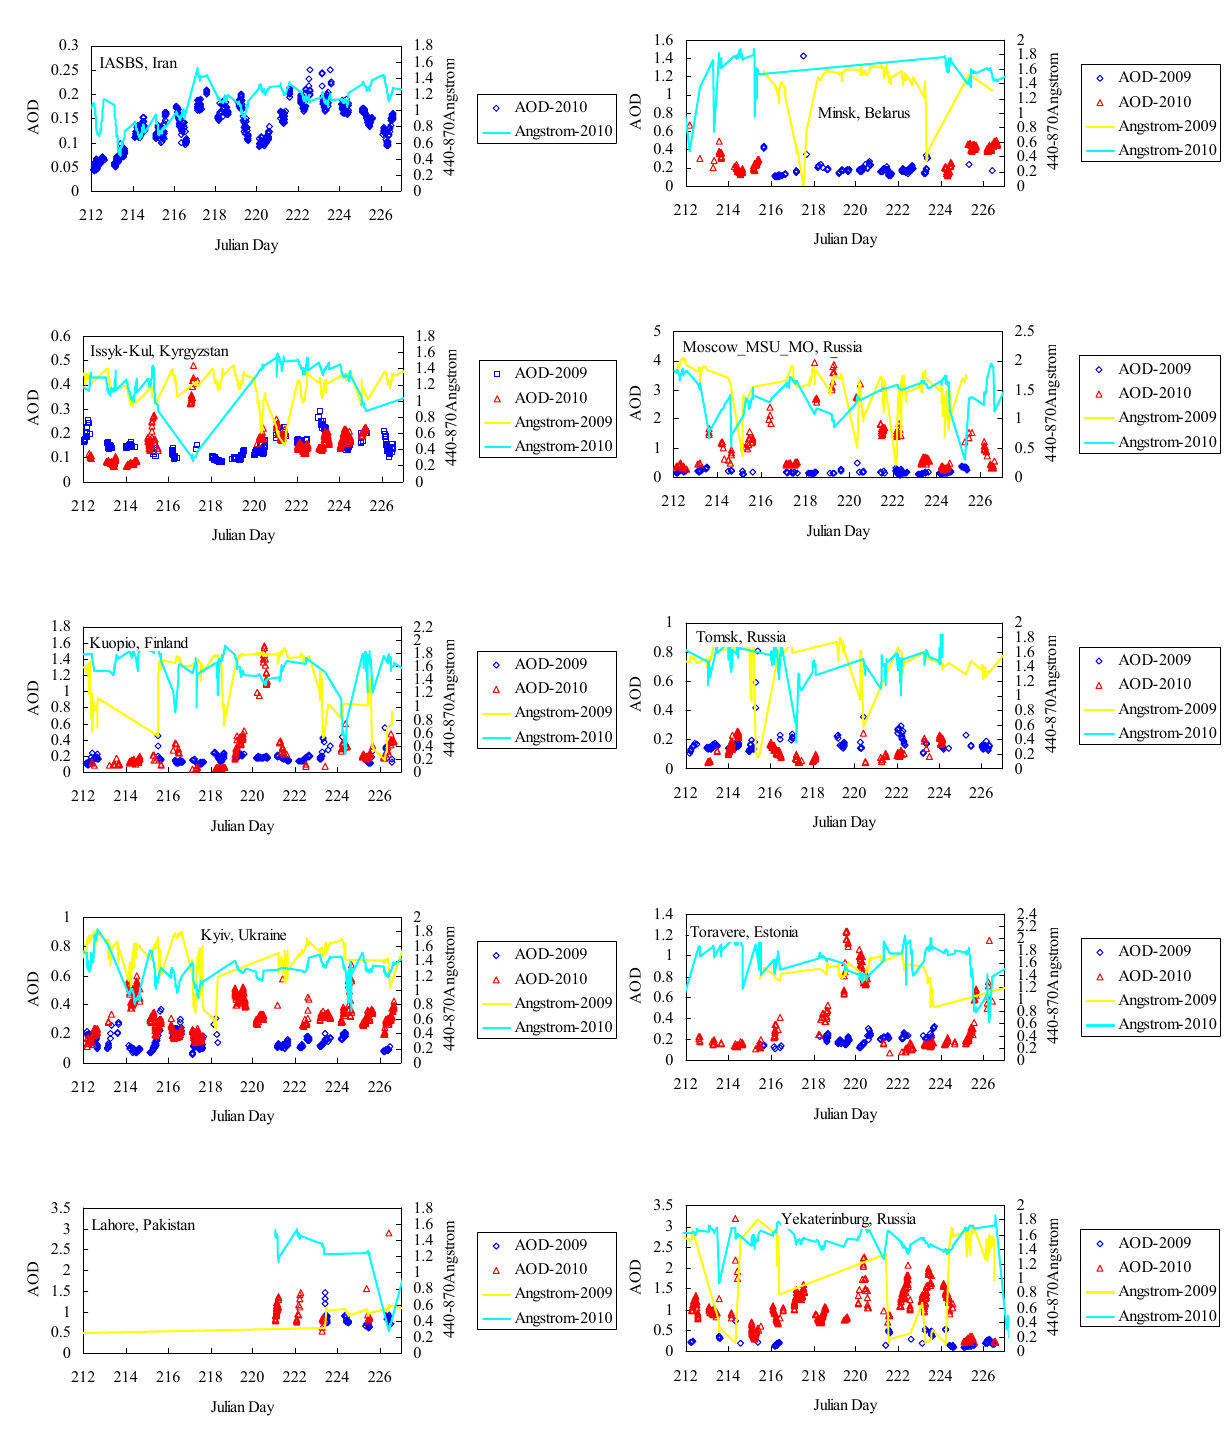
Fig. 8. Time series of aerosol optical depth at 500nm and ˚Angstr¨om exponent (400–870nm) at different AERONET sites during 16 days in both 2009 and Figure 8. Time series of aerosol optical depth at 500nm and Ångström exponent (400-870nm) at different AERONET sites during 16 days in both 2009 and 2010.